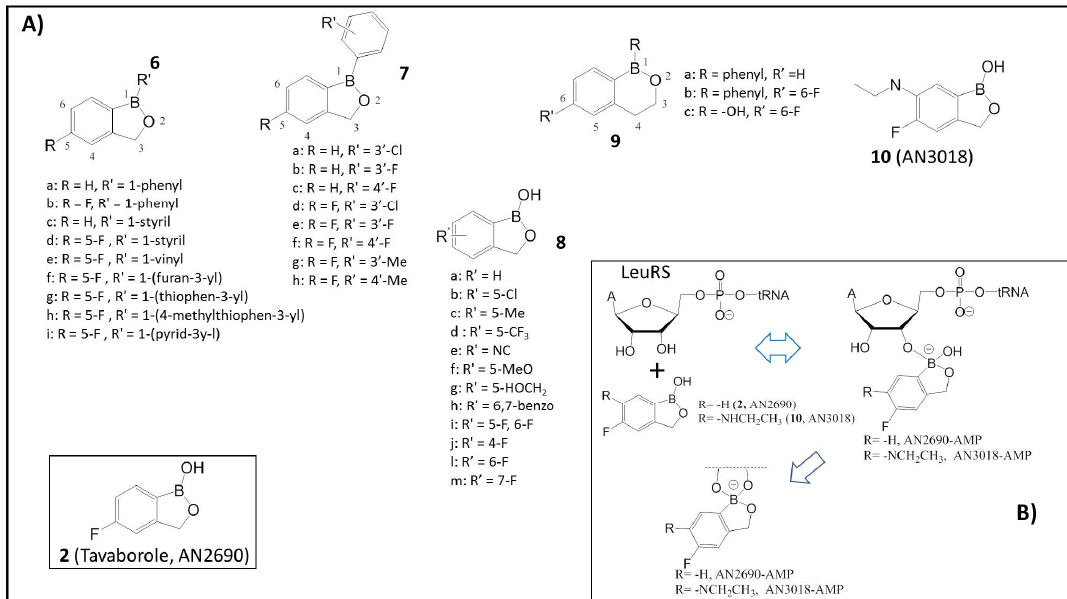
Figure 2. ( A ) Schematic representations of benzoxaborole compounds 2 (AN2690) and 6 – 10 ; ( B ) Proposed reaction mecha- nism of 2 and 10 (AN3018) on leucyl tRNA synthetase (LeuRS) resulting in spiro-product inhibitor: The sp 2 hybridized boron atom possesses an empty p-orbital that accepts electrons from the hydroxyl groups of the terminal adenosine and forms an adduct with the tRNA (Adapted from [31,32] ).